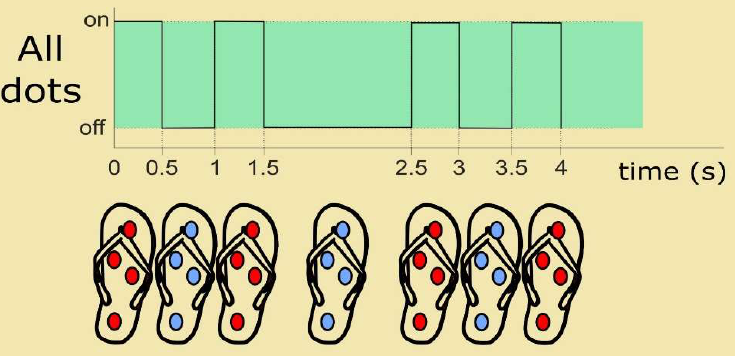
Figure 9. Vibrating pattern for stop.